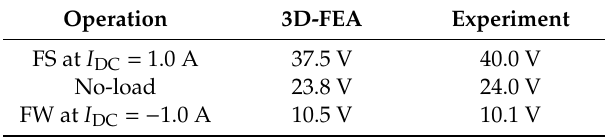
Figure 14. Measured efficiency (blue) and power losses (red) of the wireless rotor power supply system. In Table 2 and Figure 15 are depicted RMS values of back-EMF at 1000 rpm rotor speed for the three operating conditions obtained experimentally and during 3D-FEA analysis.